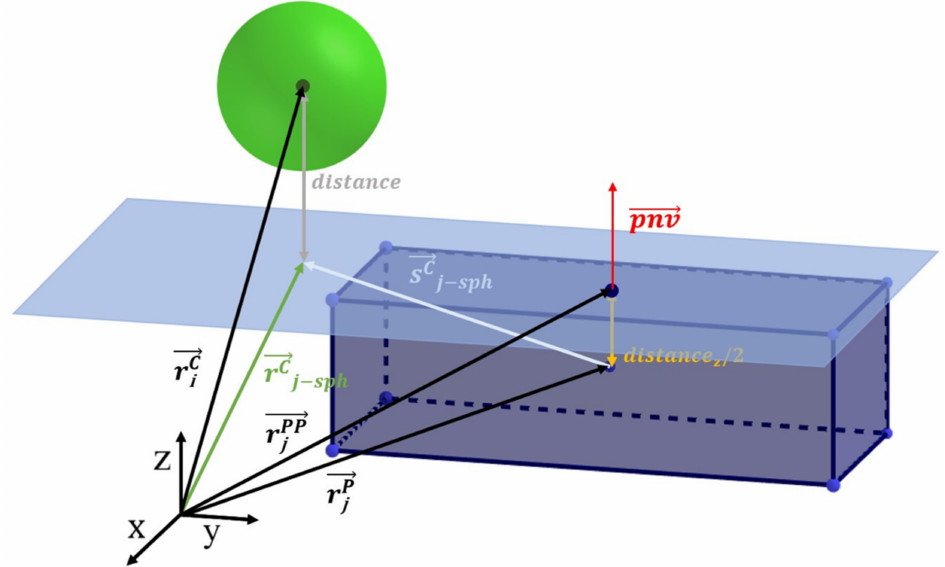
Figure 11. Projection of the center of the sphere on the plane coincident to the upper face of the parallelepiped.